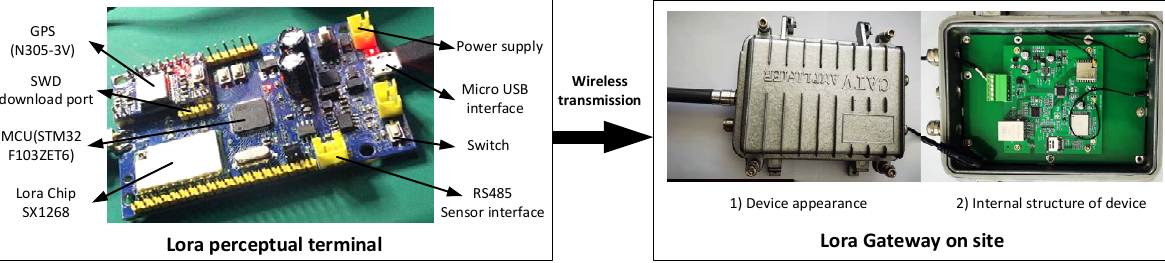
Figure 11. Physical view of LoRa information transmission terminal and gateway architecture.